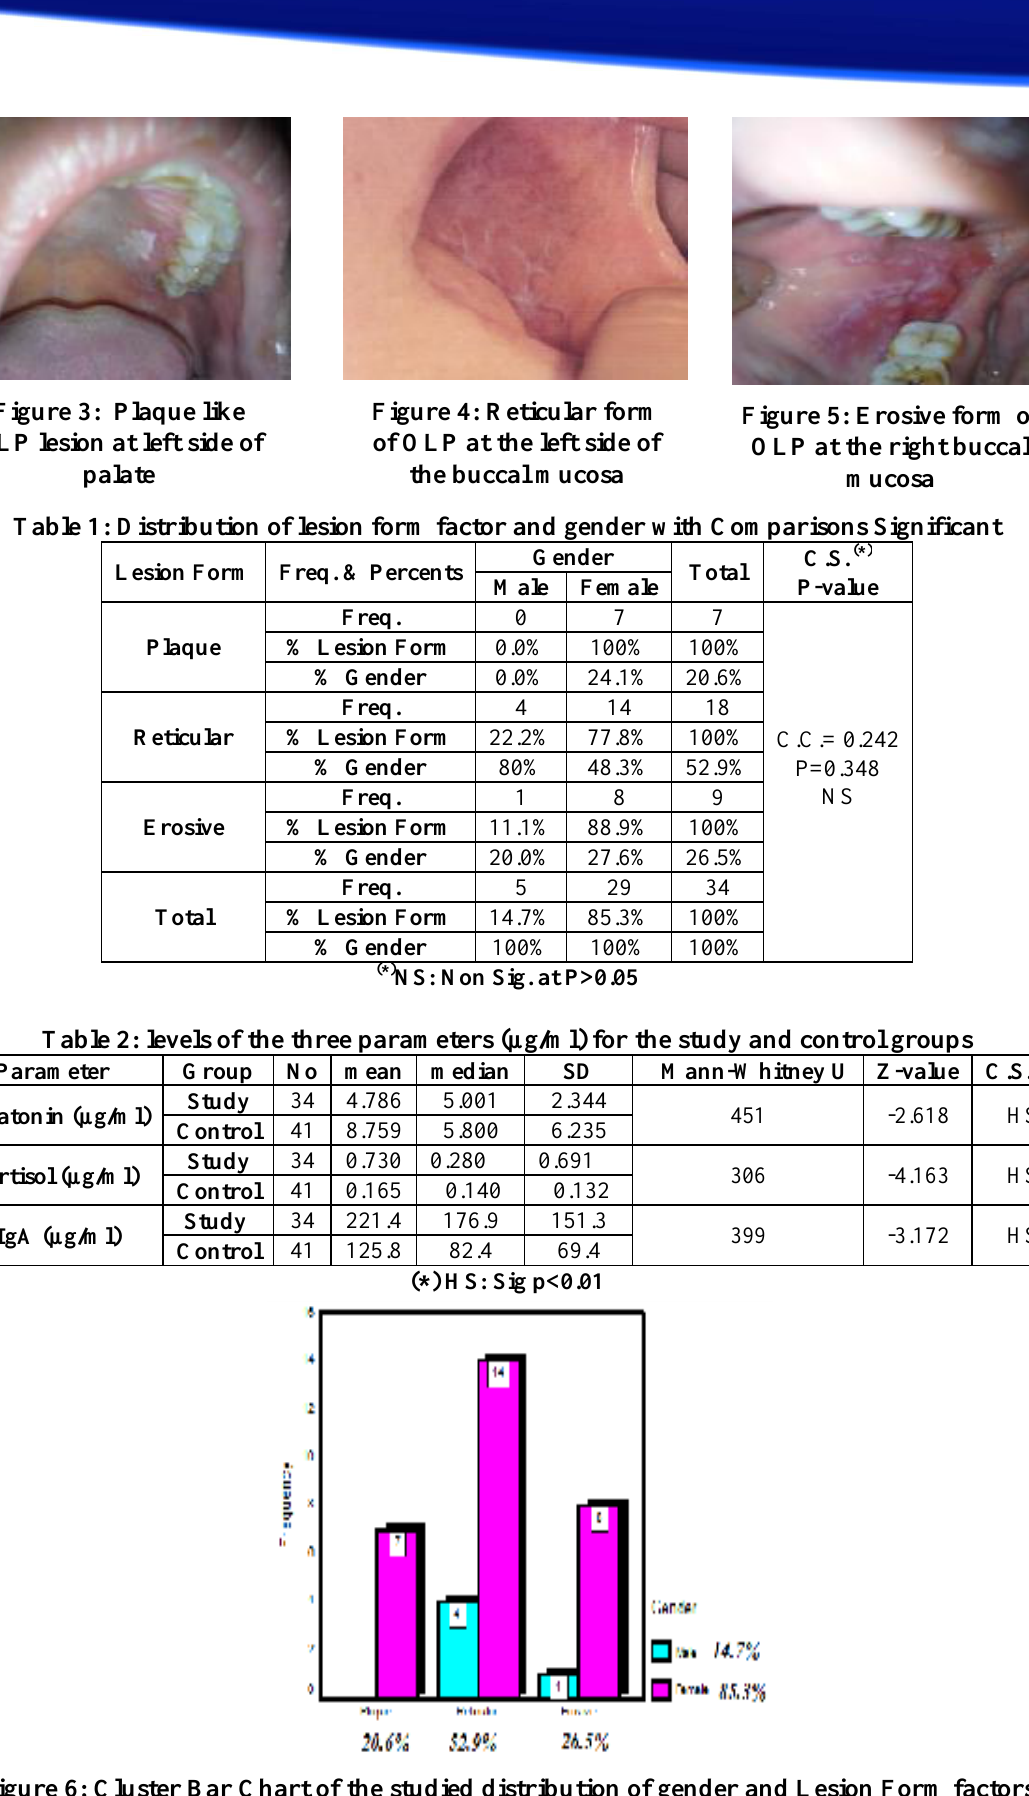
Figure 6: Cluster Bar Chart of the studied distribution of gender and Lesion Form factors